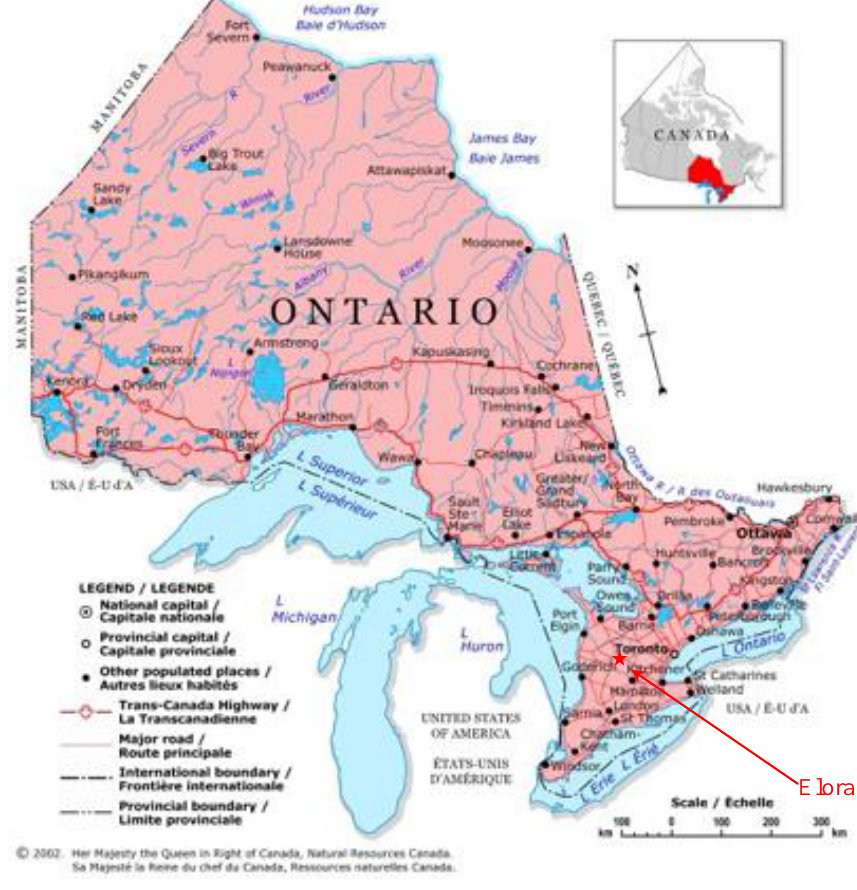
Figure 1 Geographical location of research study site in Elora, ON, Canada Fig. 1. Geographical location of research study site in Elora, ON,